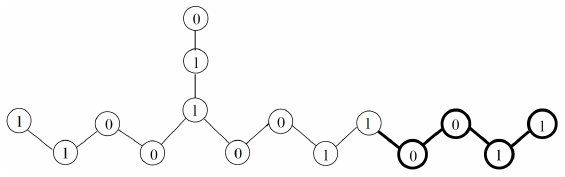
Figure 6: A tree of diameter 12 having a 1 -regular total dominating